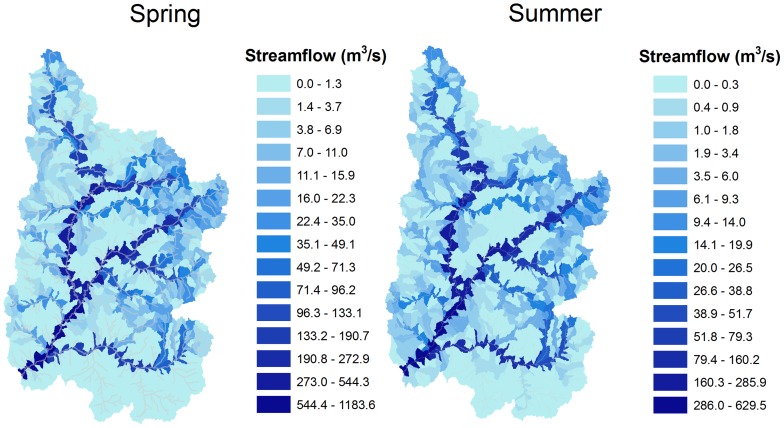
Subbasin historical streamflows of the Upper Colorado River Basin.